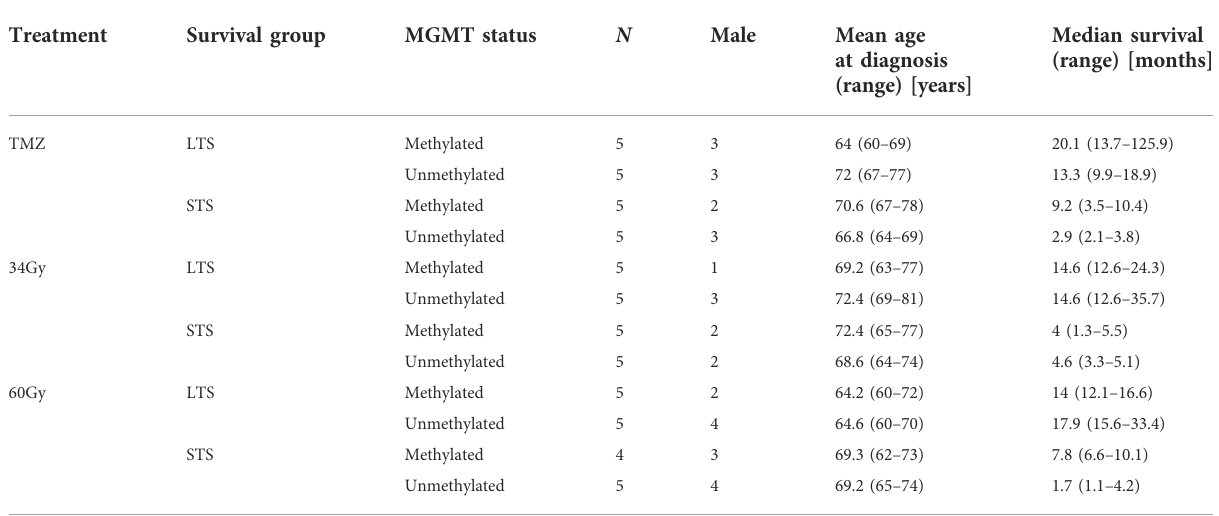
TABLE 1 Patient